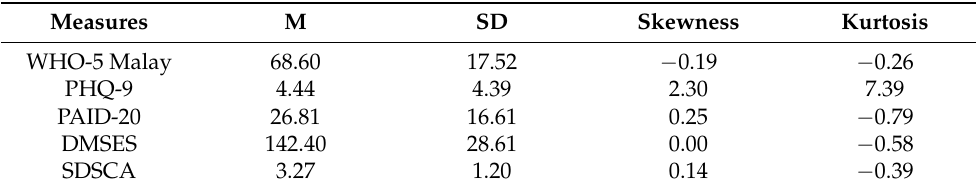
Table 1. Descriptive statistics for study